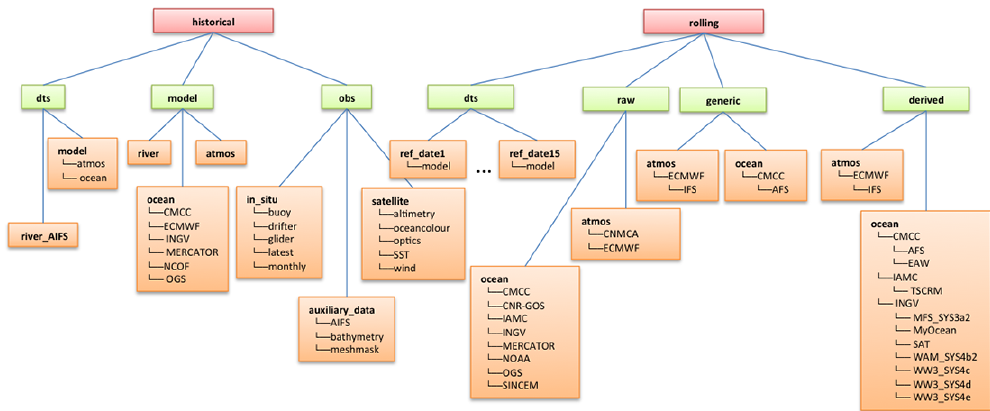
Figure 2. High-level representation of the data